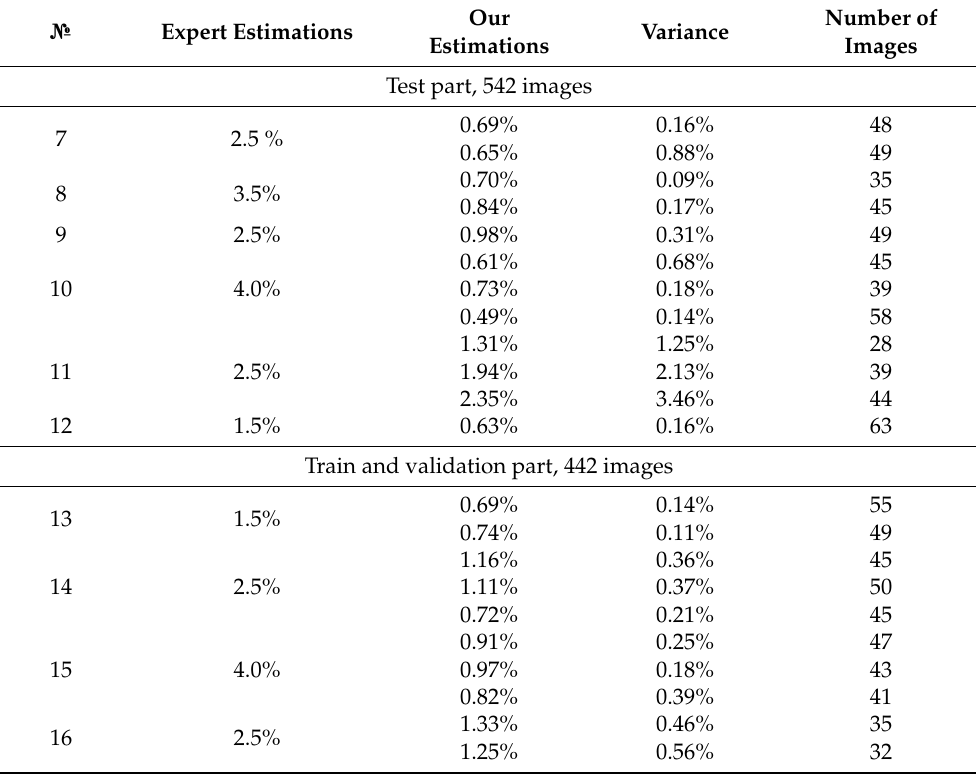
Table 4. Asbestos productivity estimation before the for dataset №